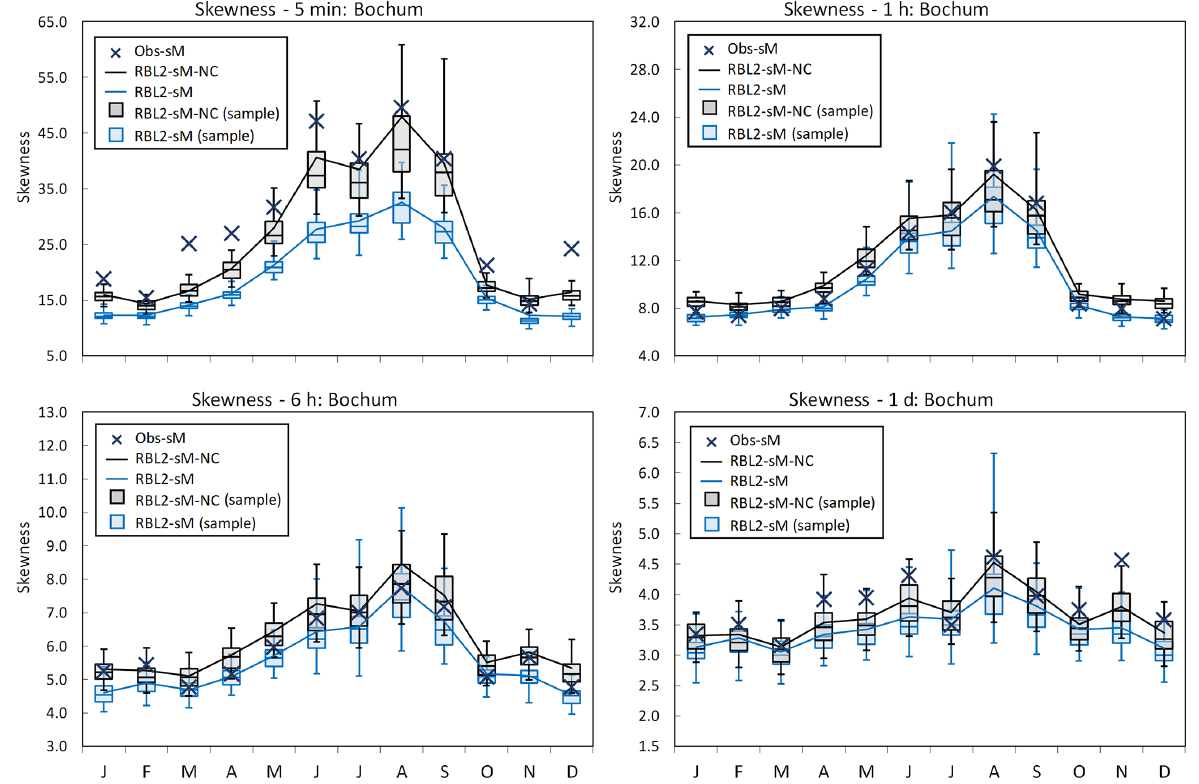
Figure 10. Coefficient of skewness by month at Bochum: the observed vs. the fitted coefficient of skewness using the RBL2 models with the original and the new solution spaces of α (RBL2-sM, light blue lines and boxplots; RBL2-sM-NC, black lines and